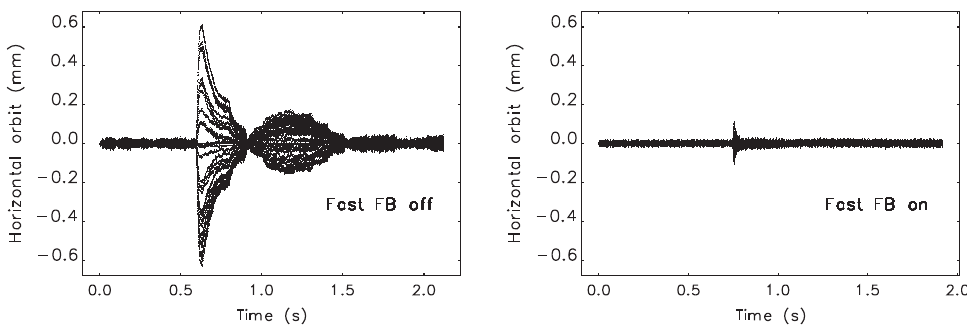
FIG. 18. Effect of induced quench on the beam orbits at all the insertion devices (IDs). Left panel: Slow orbit correction only. Right panel: Fast orbit feedback (FB) turned